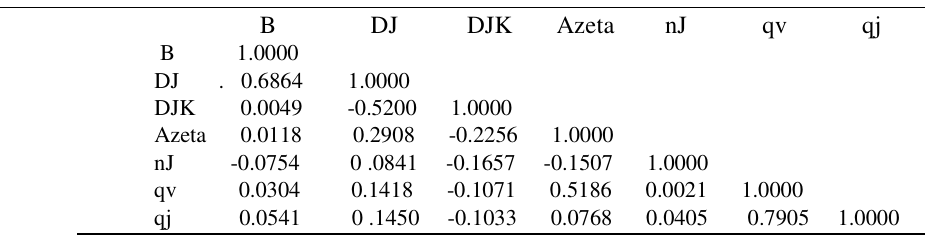
O) in v (E) = 1 2 3 1